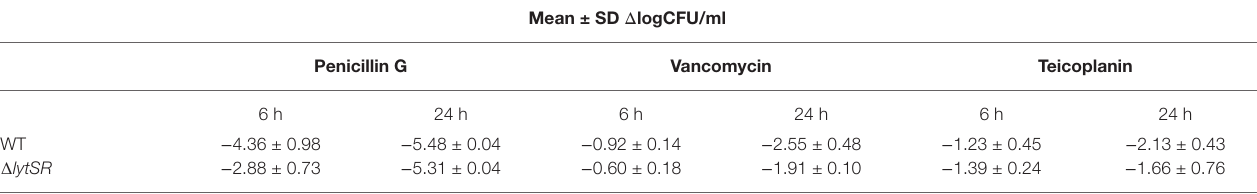
TABLE 3 | Effect of lytSR deletion on antibiotic sensitivity.